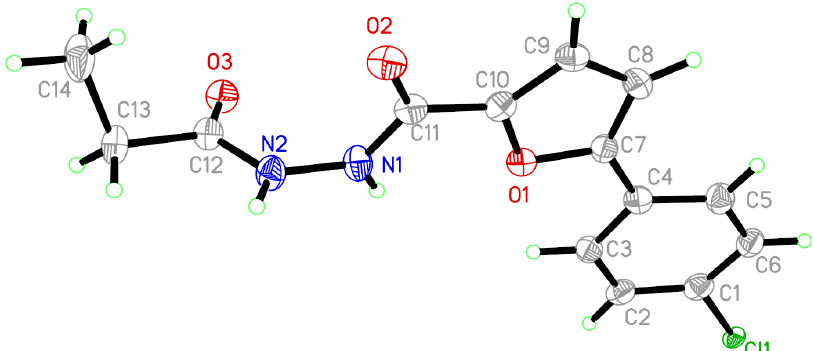
Figure 1. Molecular structure of compound III-3-2 , showing 30% probability ellipsoids; H atoms are shown as small spheres of arbitrary radii.